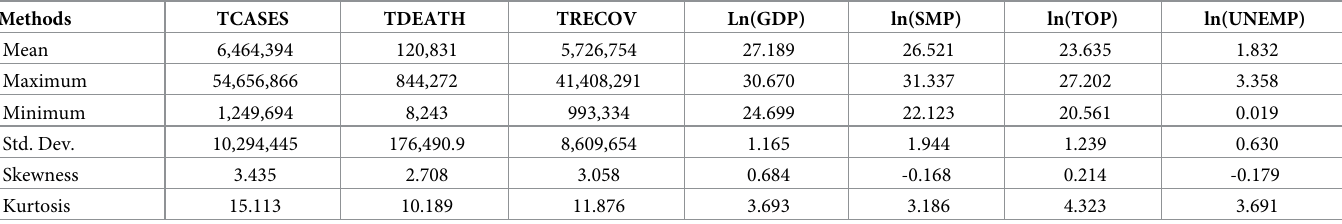
Table 2. Descriptive statistics.